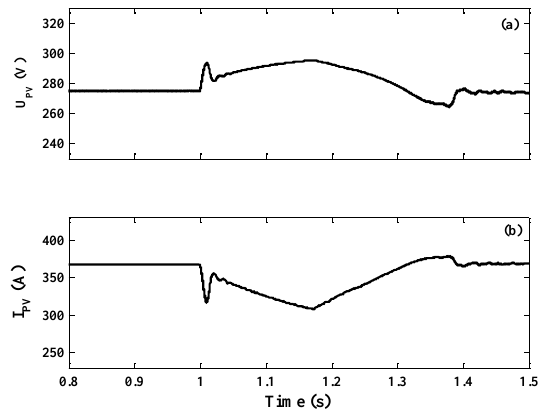
Figure 9. Characteristics of the PV panels under the symmetrical fault. ( a ) PV voltage; and ( b ) PV current.